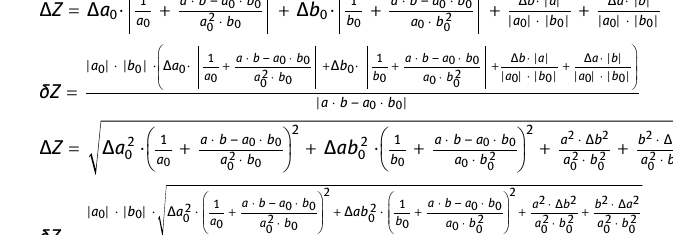
Estimation of the measurement uncertainty of the quantity being a contraction Z for a specimen with a rectangular cross - section Equations ( 9 ) and ( 5